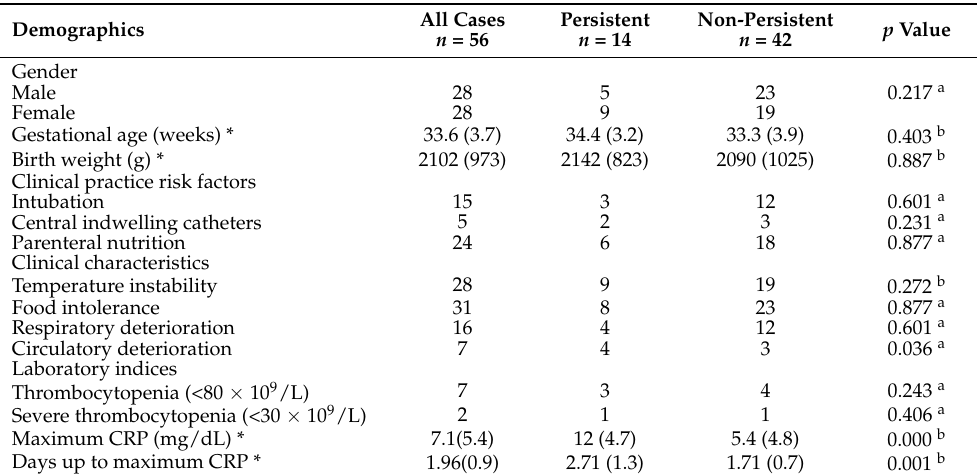
Table 1. Demographics, clinical and laboratory characteristics of the studied population ( n = 56), cases with persistent ( n = 14) and cases with non-persistent ( n = 42) CoNS bacteremia the period 2016–2017.